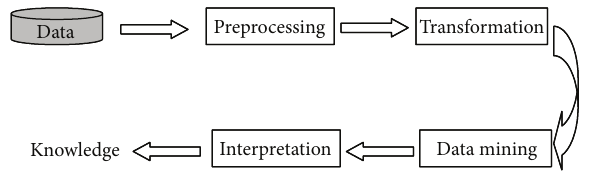
Figure 1: The steps of the KDD